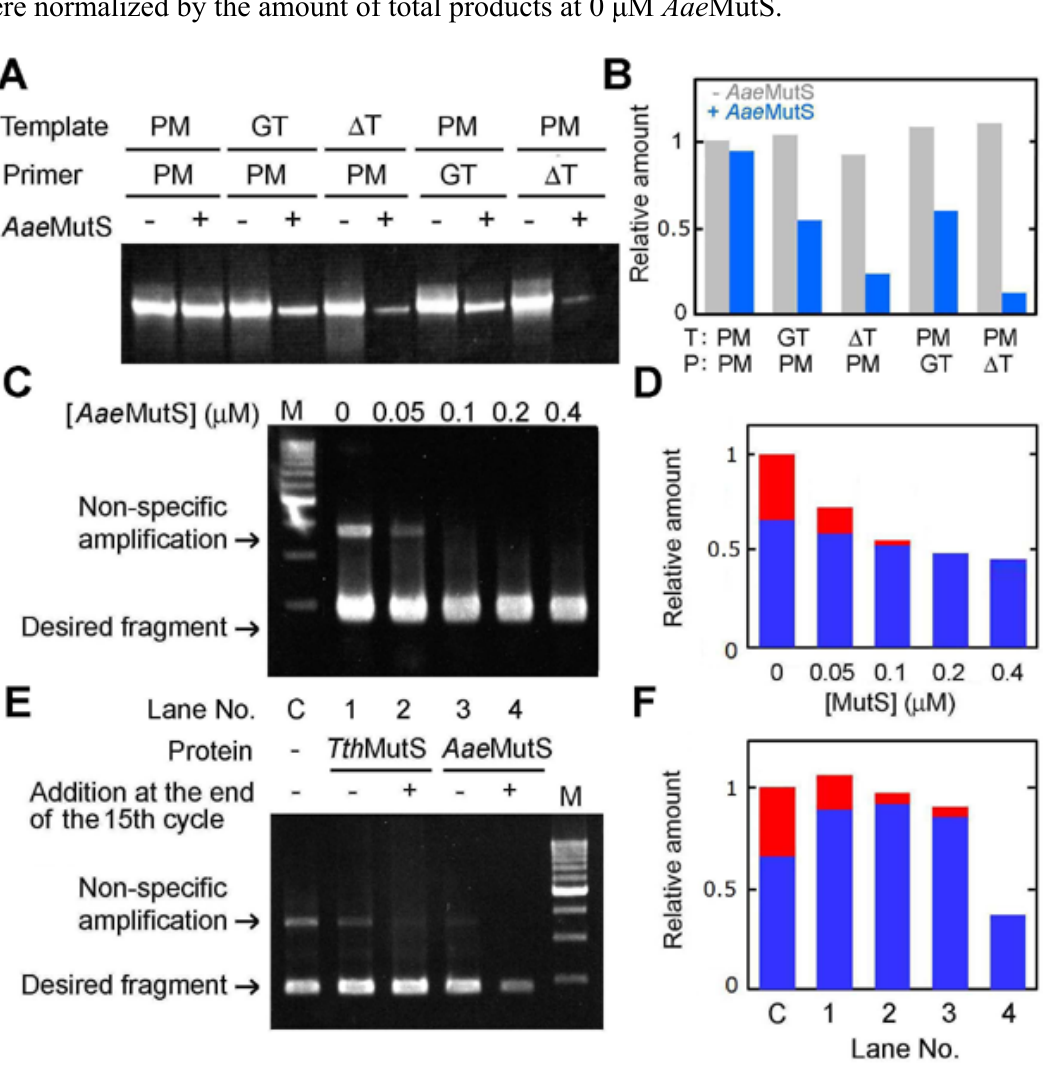
Figure 9. Effects of Aae MutS on amplification of an 80-bp template. ( A ) Results of amplification of an 80-bp template in the presence of 0.2 μ M Aae MutS. PM, GT and Δ T indicate perfectly matched, GT-mismatched and unpaired T-containing primers or templates, respectively; ( B ) Quantification of the relative amounts of PCR products from ( A ); ( C ) The same experiment as in Figure 6A was performed using Aae MutS. The primers at 0 μ M Aae MutS; ( D ) Quantification of the relative amounts of nonspecific